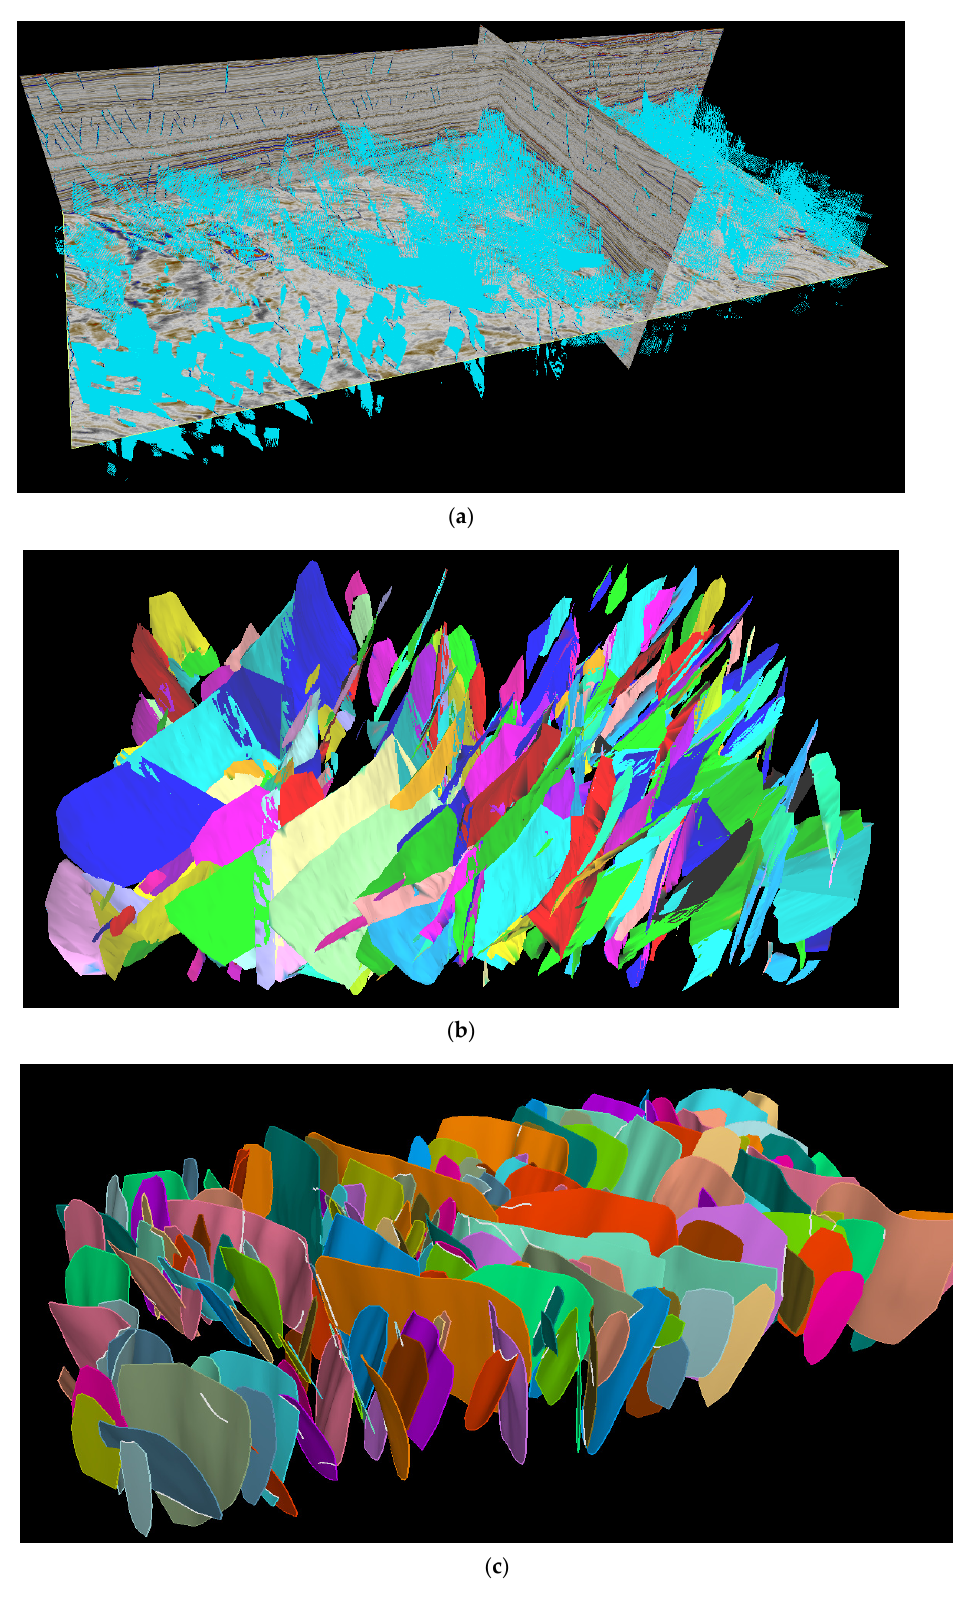
Figure 10. Results of fault modelling using ( a ) original fault cube, ( b ) conventional (automatic) approach, and ( c ) clustering (the proposed method). Automatic fault extraction methods show low connectivity between fault models; however, the proposed method shows high connectivity with the possibility of individual fault extraction through clustering.